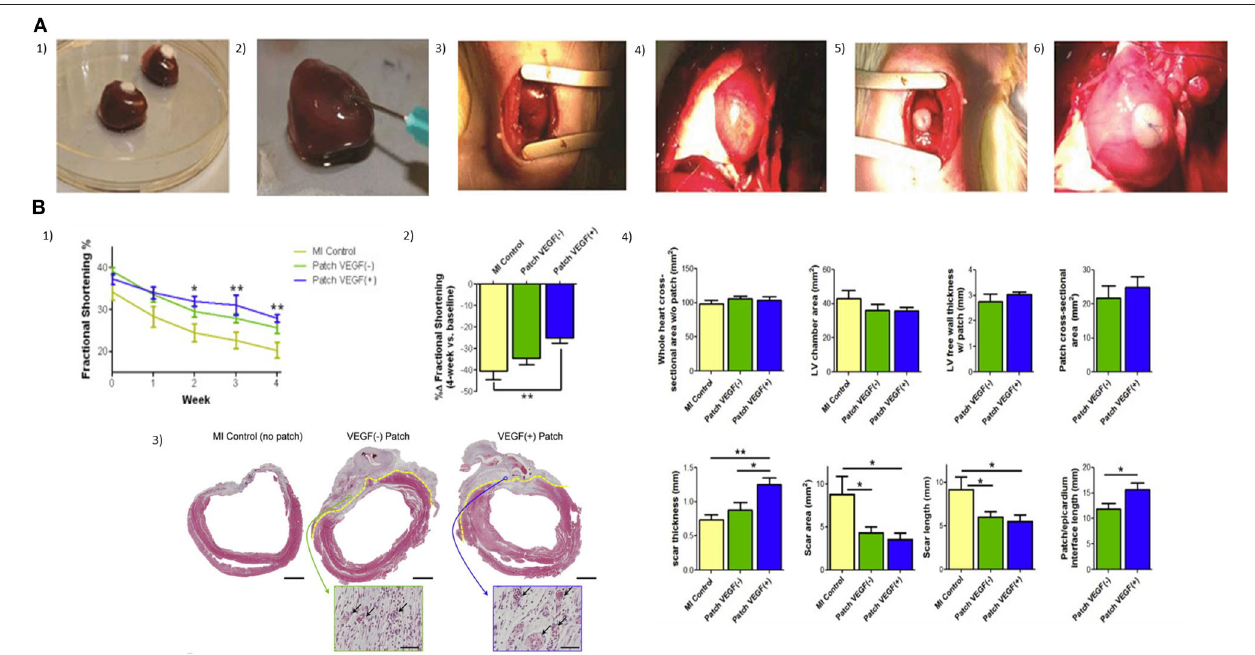
FIGURE 7 | (A) Two injectable gels (chitosan and alginate) and two epicardial patches (collagen β -glycerophosphate and alginate) were compared in terms of acute retention of stem cells in the infarcted heart (1, 2). Injection technique and volume, patch size, and attachment were optimized with rat hearts ex-vivo ; (3) Mini-thoracotomy and guide suture placement; (4) Myocardial blanching was observed after ligation of the LAD; (5) Patches were placed at the infarct border zone cell-seeded side down with a single suture; (6) Patches remained in place for 24h, when a bilateral thoracotomy was performed and aorta was cannulated for perfusion (191). (B) Epicardial microsphere patches improve cardiac functioning and VEGF ( + ) patches improve cardiac morphometry post-MI. (1) Myocardial infarction (MI) was induced in mice by left anterior descending artery ligation. Patches were transplanted onto the LV surface of the heart 4 days after MI, and fractional shortening (% FS) was measured for 4 weeks; (2) To compensate for variability at baseline (1-week post-MI, pre-implantation, t = 0) FS was also expressed as a percentage change over the 4-week time course (% 1 FS); (3) Tissue morphometry was assessed using Masson’s trichrome stain. Patch/epicardial interference were identified under high magnification and are indicated with a broken yellow line (scale bar = 2mm). Insets show vascular structure (arrows) in the patch areas (scale bar = 50 µ m); (4) Left ventricular and patch morphometry were quantified using whole-slide scanned trichrome stained cross-sections (